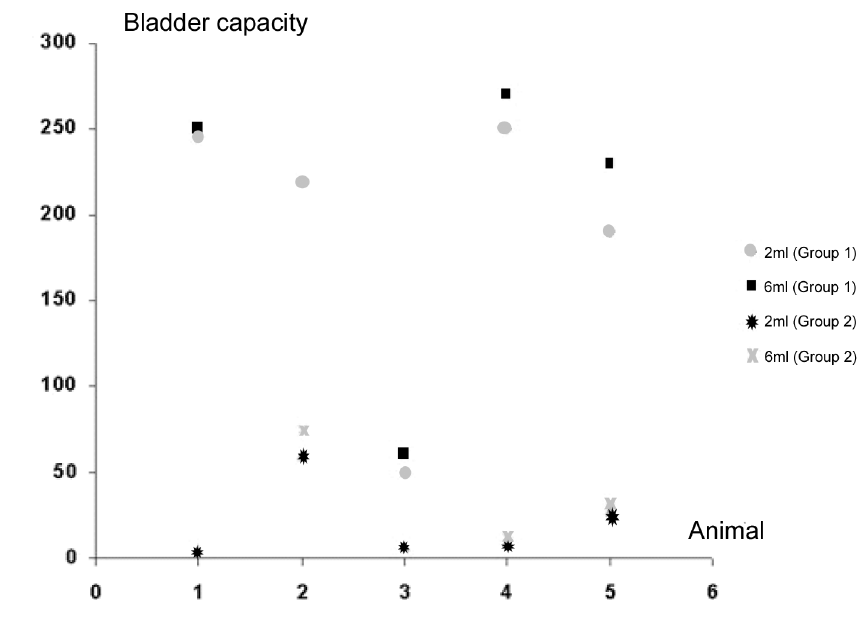
Figure 7 – Bladder capacity of animals from both groups, at 2 months and at 6